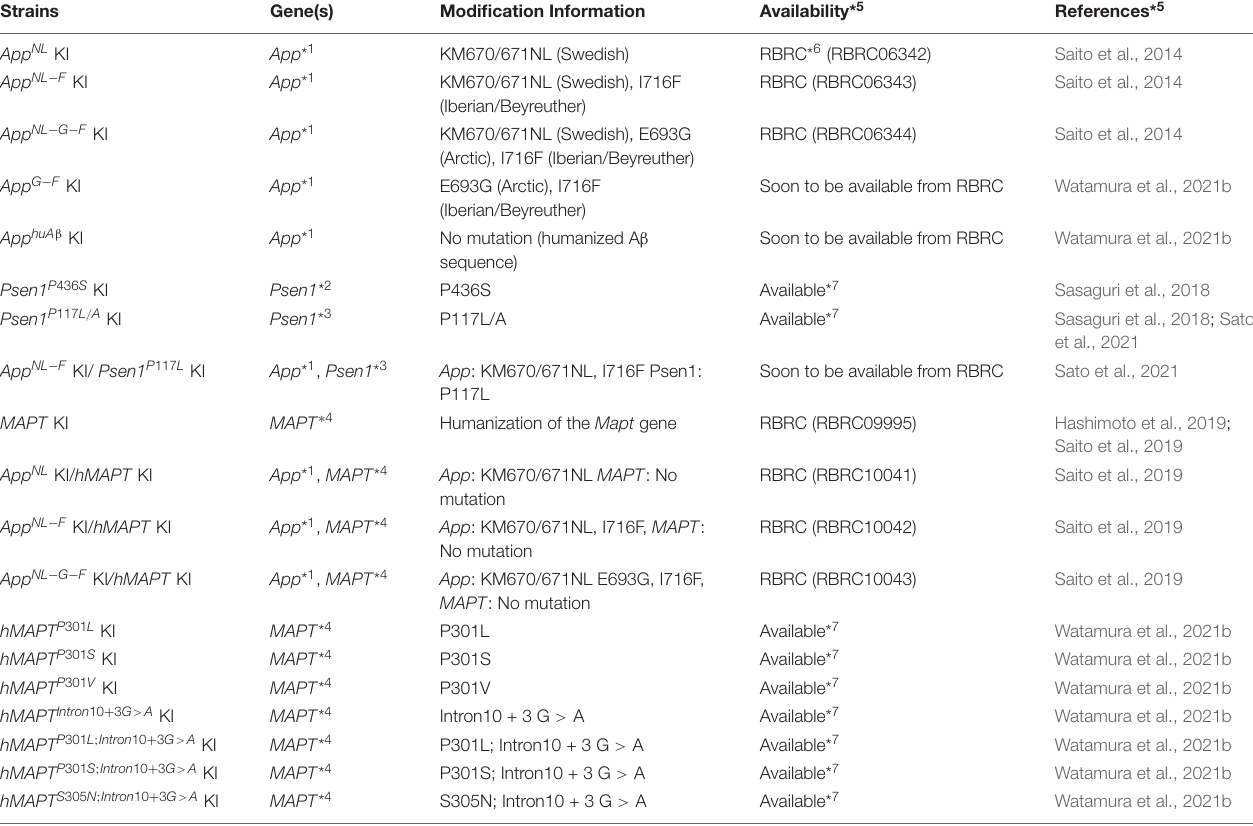
TABLE 2 | List of mutant mice that are and will be made available to the research community.